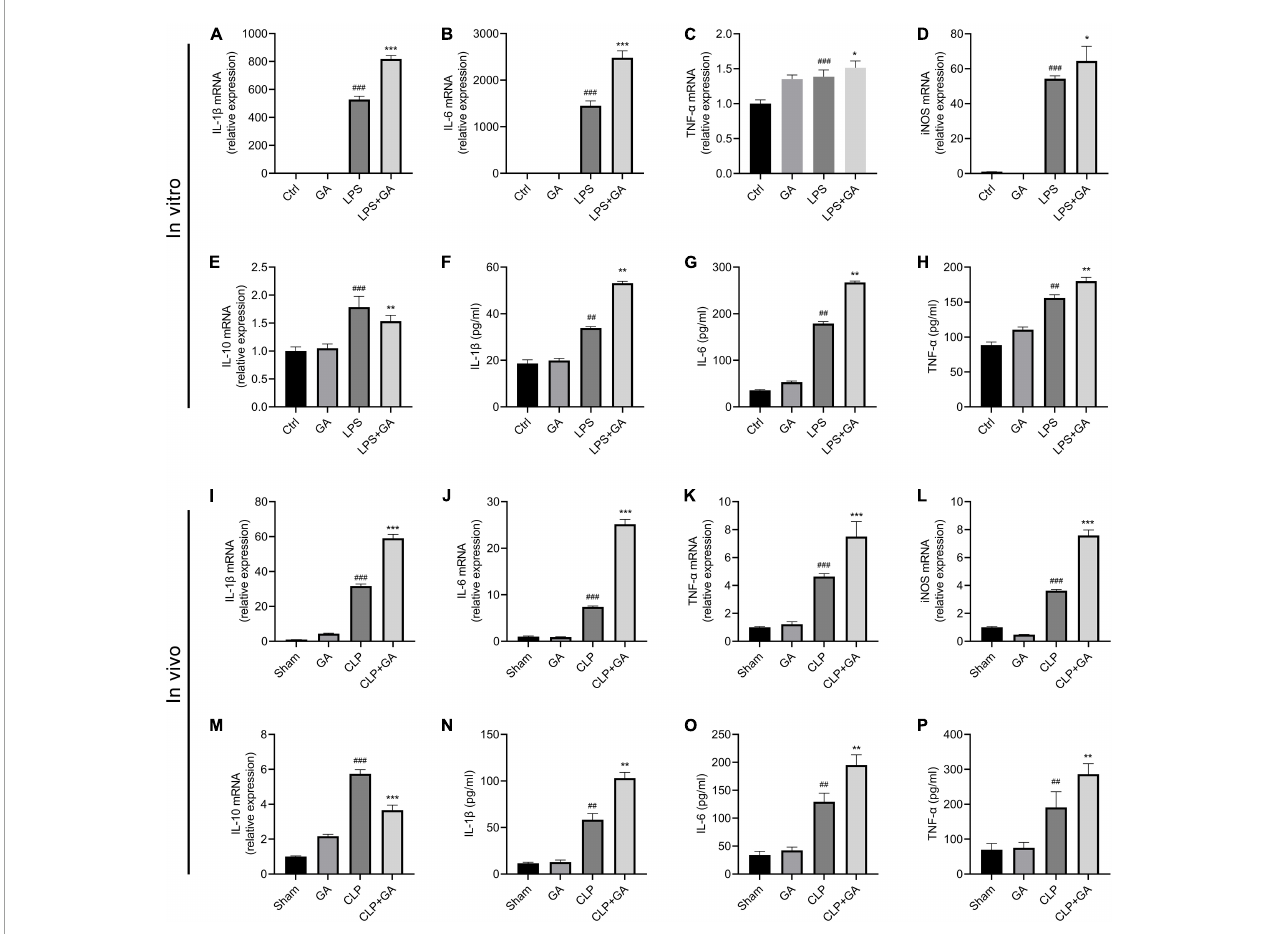
FIGURE1 Ginkgolic acid (GA) upregulates inflammatory response in vitro and in vivo . RAW 264.7 cells and their culture supernatants were collected 24 h after lipopolysaccharide (LPS) stimulation. The mRNA levels of (A) IL-1 β , (B) IL-6, (C) TNF- α , (D) iNOS, and (E) IL-10 were detected by real-time polymerase chain reaction (RT-PCR) ( n = 6). The protein levels of (F) IL-1 β , (G) IL-6, and (H) TNF- α in the cell culture supernatant were detected by enzyme-linked immunosorbent assay (ELISA) ( n = 3). Data were calculated with the mean ± SD. ## P < 0.01, ### P < 0.001 versus the Ctrl group; ∗ P < 0.05, ∗∗ P < 0.01, ∗∗∗ P < 0.001 versus the LPS group. PMs and serum samples were collected from mice ( n = 4) at 24 h after CLP. The mRNA levels of pro-inflammatory factors (I) IL-1 β , (J) IL-6, (K) TNF- α , (L) iNOS, and anti-inflammatory factor (M) IL-10 in PMs were detected by RT-PCR. The protein levels of (N) IL-1 β , (O) IL-6, and (P) TNF- α in serum ( n = 6) were detected by ELISA. Data were calculated with the mean ± SD. ## P < 0.01, ### P < 0.001 versus the Sham group; ∗∗ P < 0.01, ∗∗∗ P < 0.001 versus the CLP